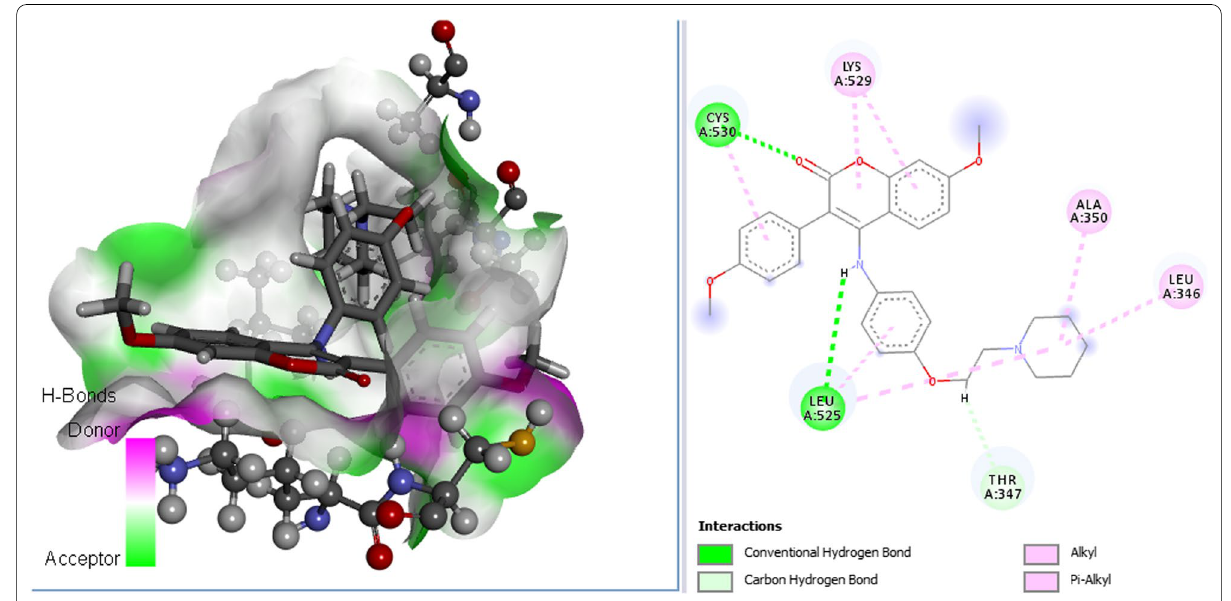
Fig. 15 3D and 2D interaction mode of the reference compound with the active site of the ER +